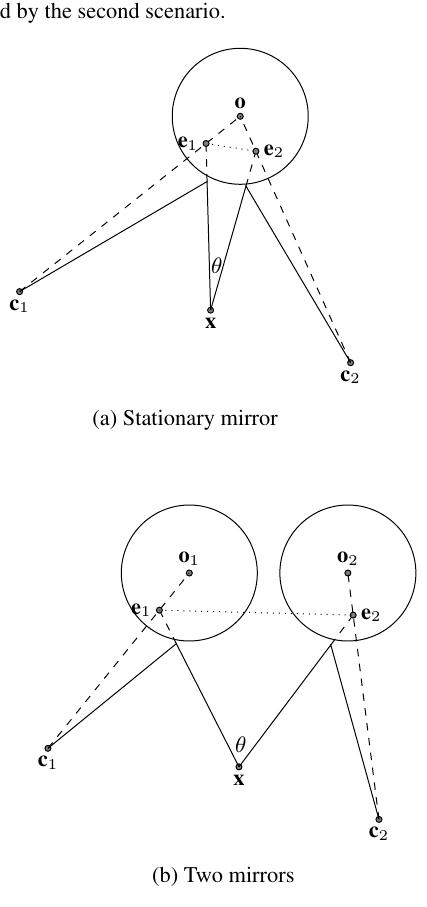
Figure 3. Mapping using reflection from spherical surfaces